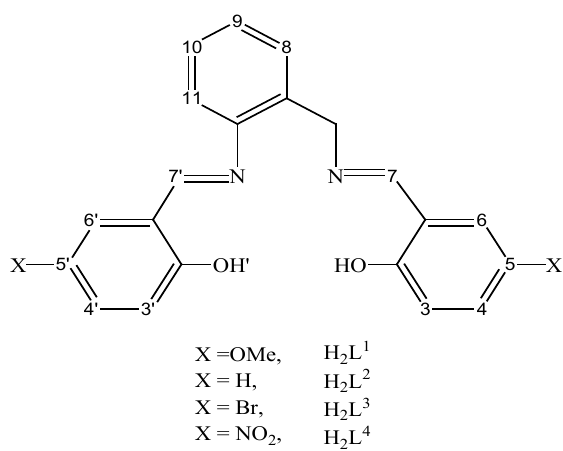
Scheme 1. Schematic representation of the ligands and